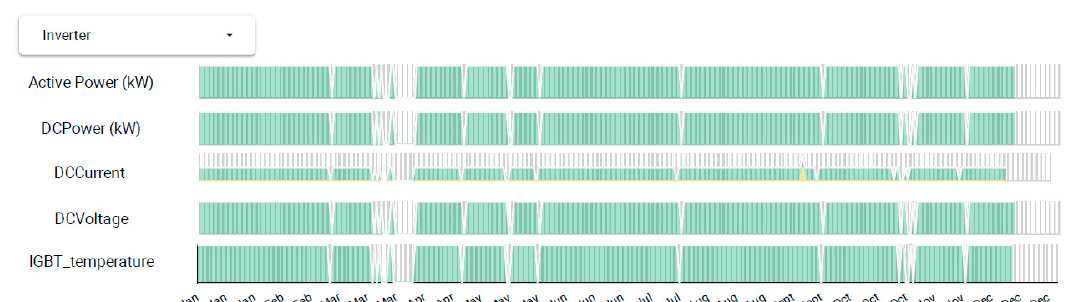
Figure 12. Behavior of signals on the inverter timeline.